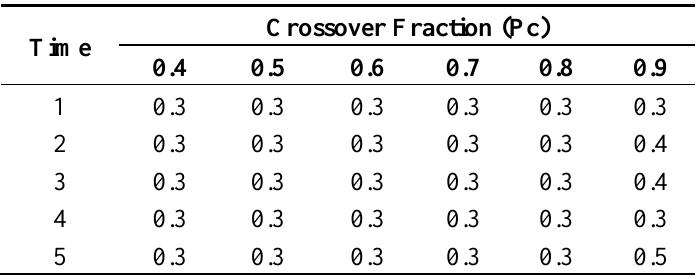
Table 5. Errors in the retrieved land surface temperatures with different crossover fractions in the genetic